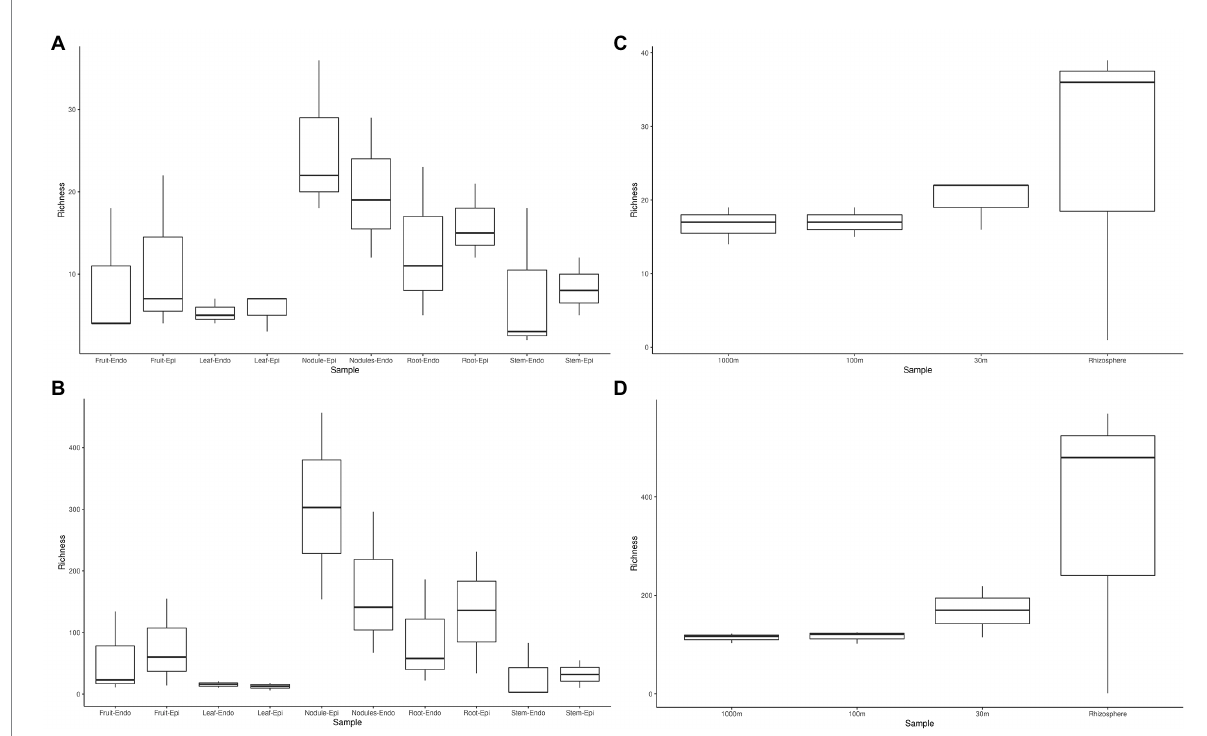
FIGURE 2 Phylum and genus level alpha diversity of Coriaria myrtifolia phytomicrobiome, soil, and rhizosphere microbiomes. (A,B) represent C. myrtifolia phytomicrobiome, while (C,D) represent C. myrtifolia soil and rhizosphere microbiomes. A and C are at the phylum-level, while panels show the genus-level diversity. Boxes represent 25 to 75th percentile variance around the mean. Whiskers represent 1.5 interval quartile ranges. Data points outside of the whiskers are considered outliers and are plotted